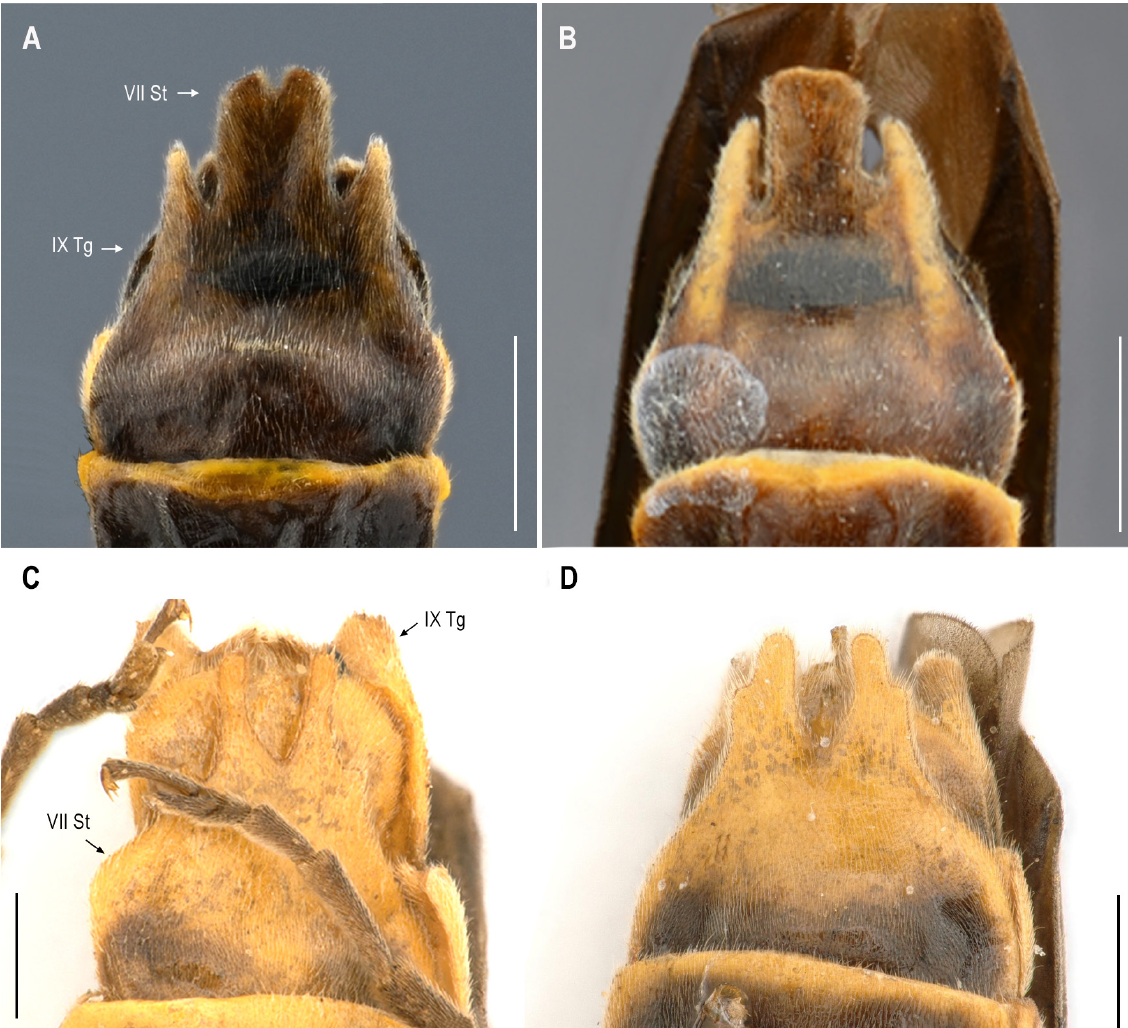
Fig. 9. Variations in the VII th sternite of species of Trypheridium Brancucci, 1985, ♀♀. A–B . Trypheridium kashmiricum sp. nov. C–D . Trypheridium nuristanicum (Wittmer, 1956). Abbreviations: VII St = 7 th sternite; IX Tg = 9 th tergite. Scale bars: